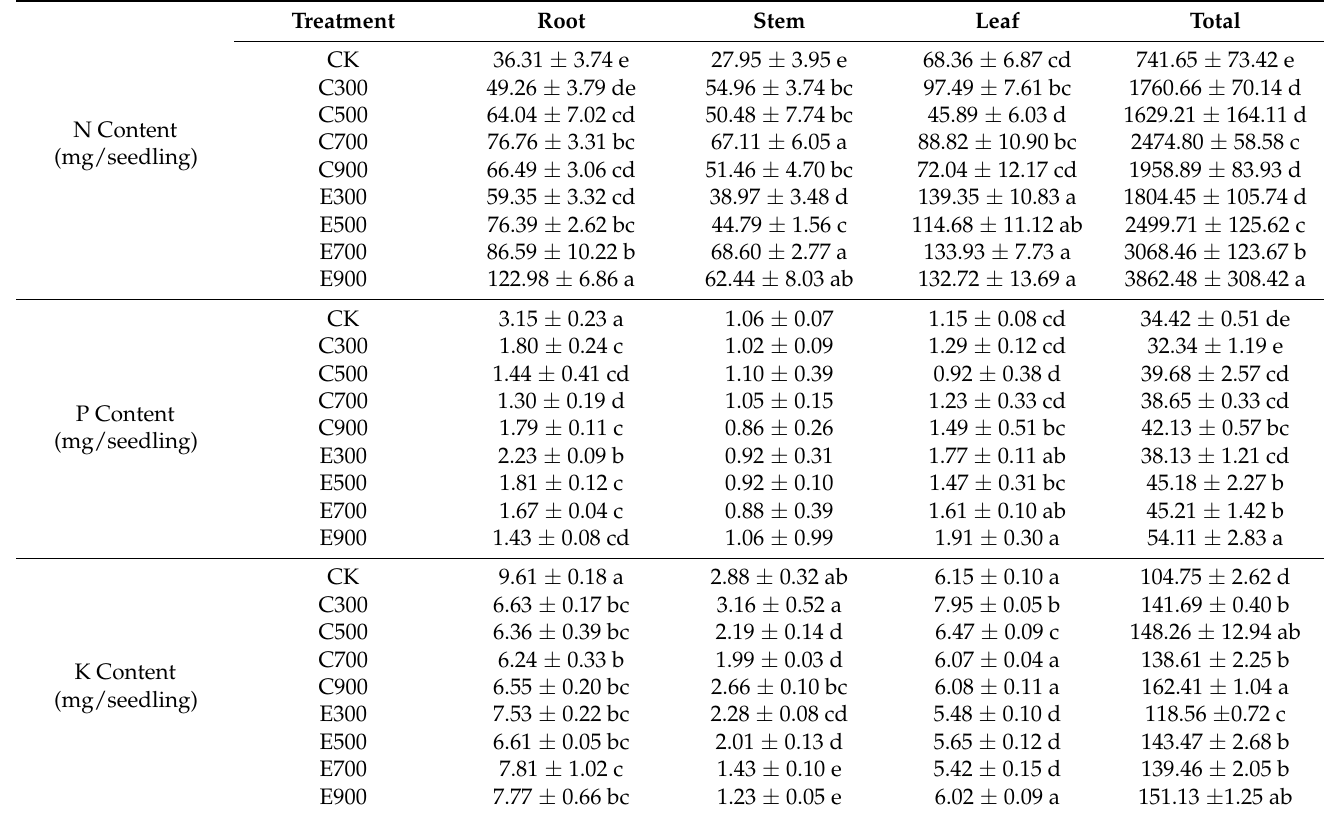
Table 3. Effects of fertilization on K, P, and K contents of roots, stems, and leaves of Q. nuttallii container